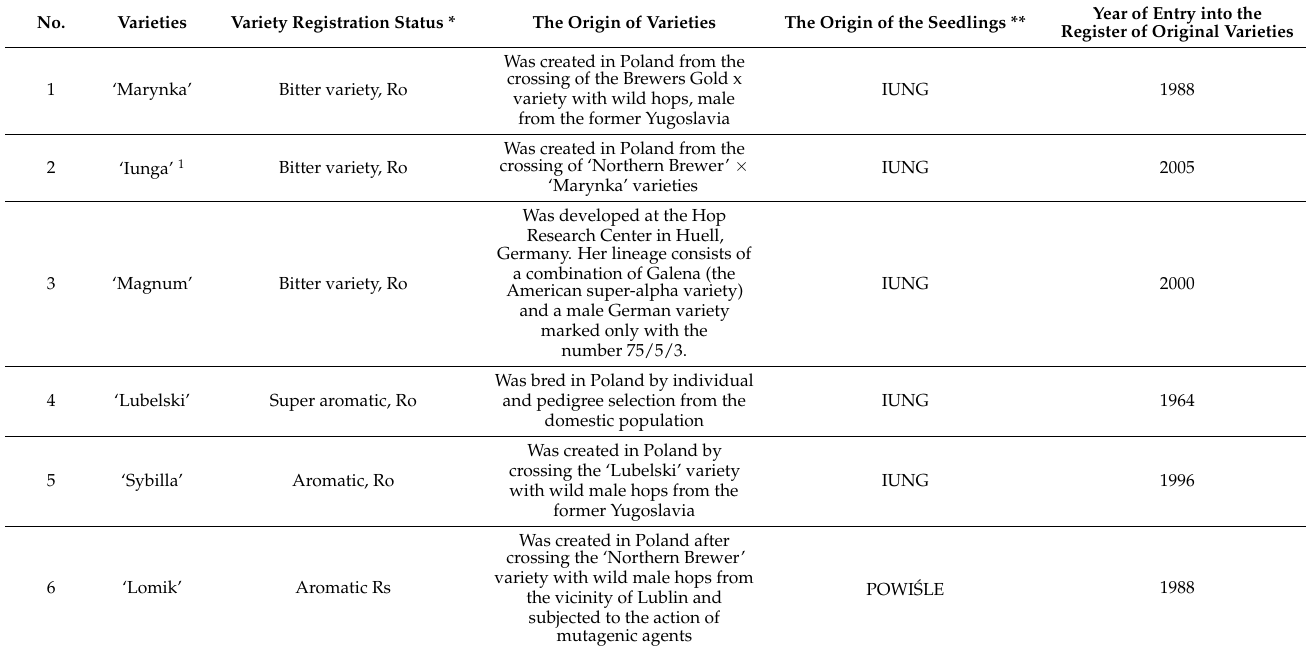
Table 2. The status of hop varieties and their